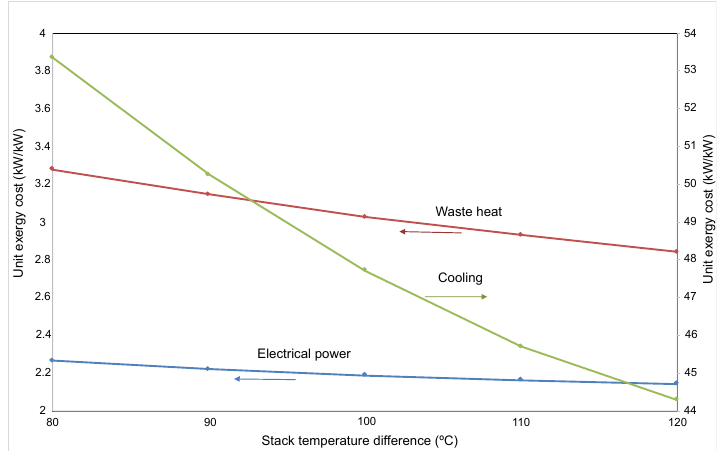
Figure 10. Variation of the unit exergy cost of electricity and exhaust gases as a function of the stack temperature